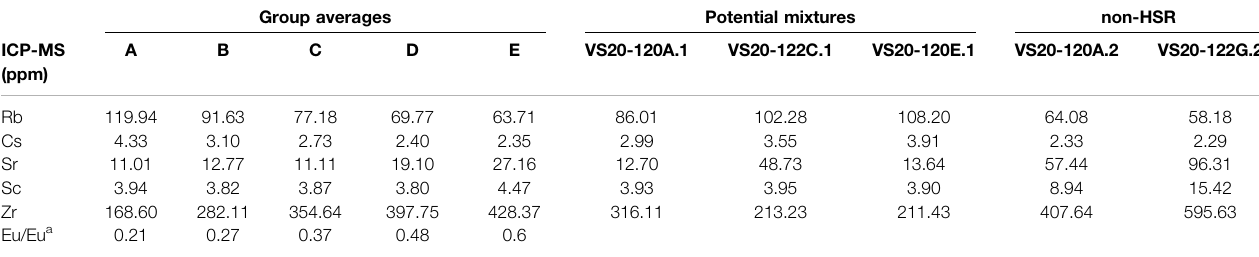
TABLE 2 | ( Continued ) Average geochemical compositions for Rattlesnake Tuff high-silica rhyolite Groups.